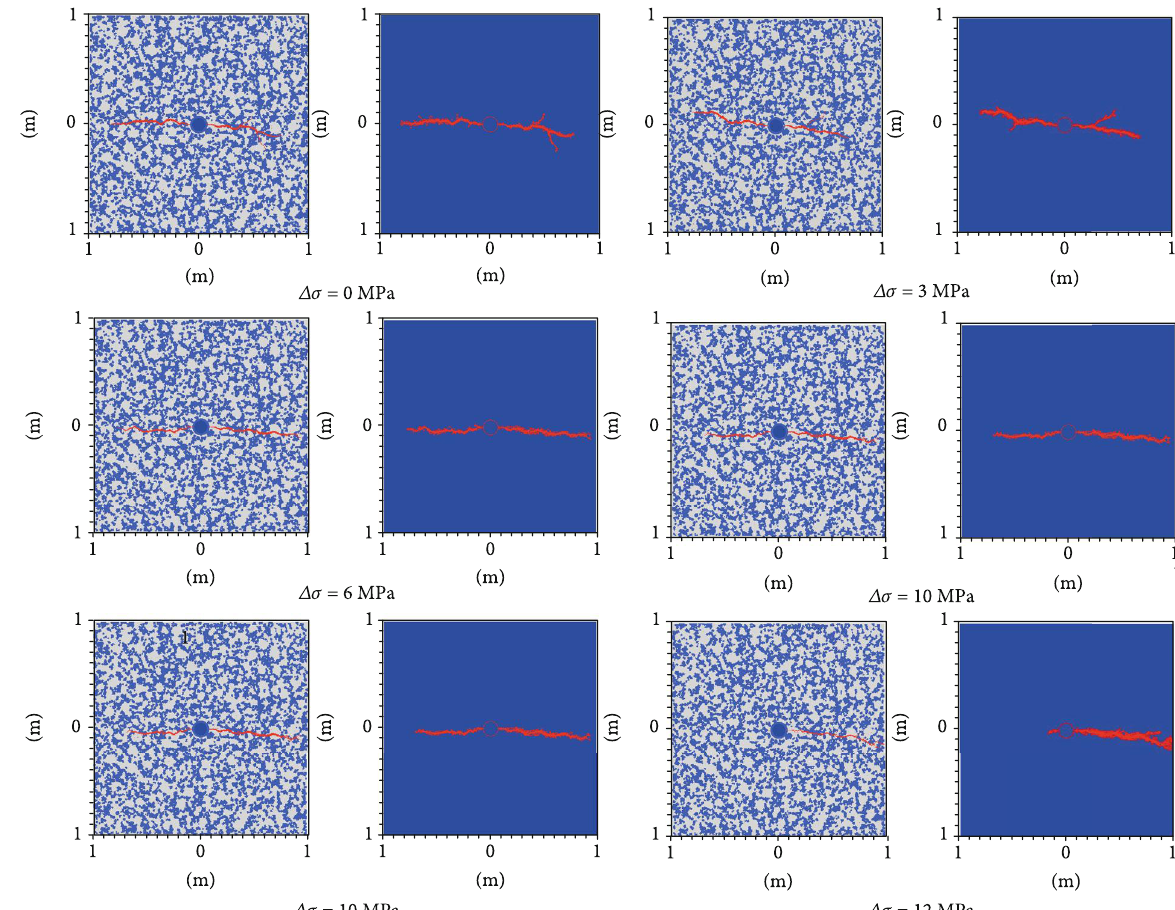
Figure 19: Propagation morphology of HF under di ff erent horizontal stress di ff